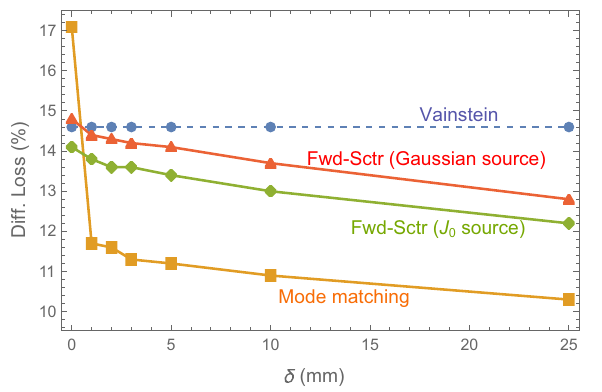
FIG. 13. Plot of the data shown in Table